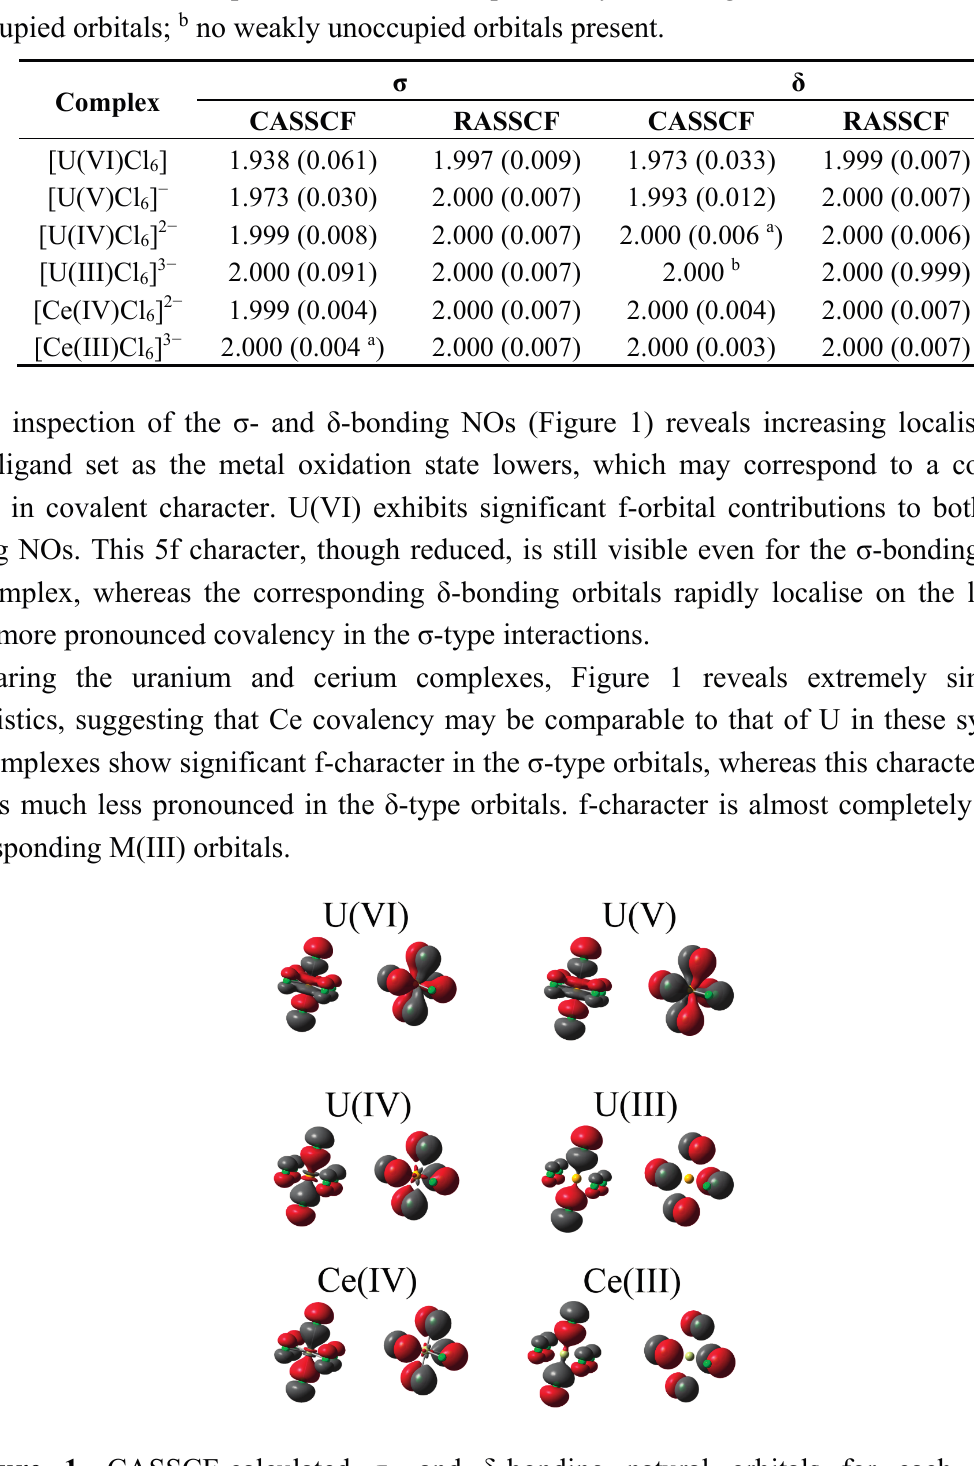
Figure 1. CASSCF-calculated σ - and δ -bonding natural orbitals for each system considered in this study. All orbitals rendered at an isosurface of 0.02